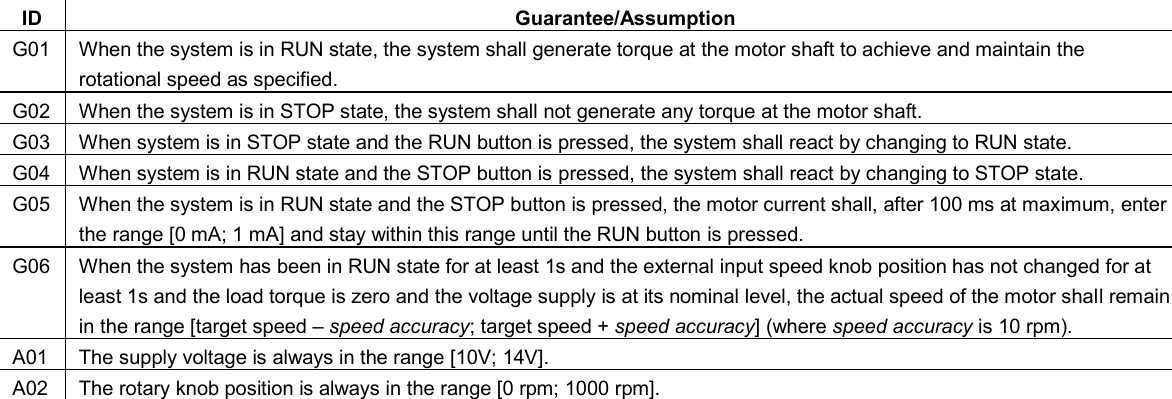
Table 1. A selection of requirements and assumptions for the DC Drive system